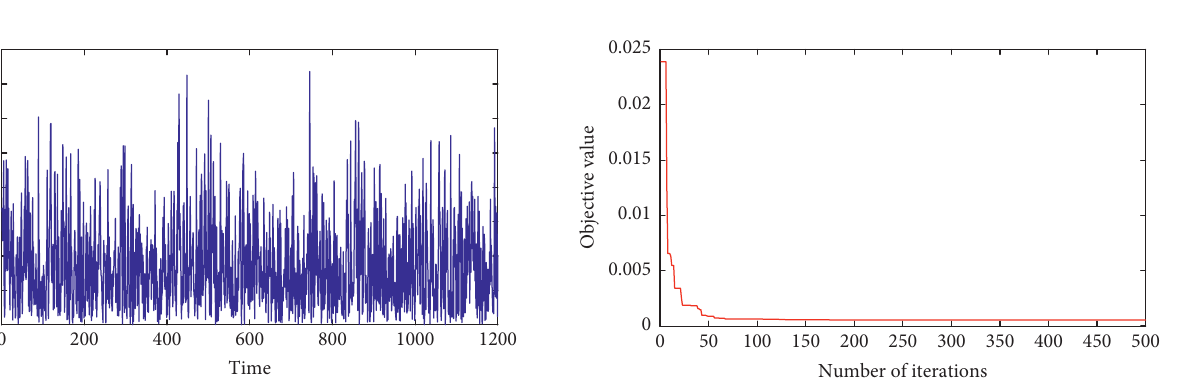
Figure 9: The MSFE obtained by JADE with archive .